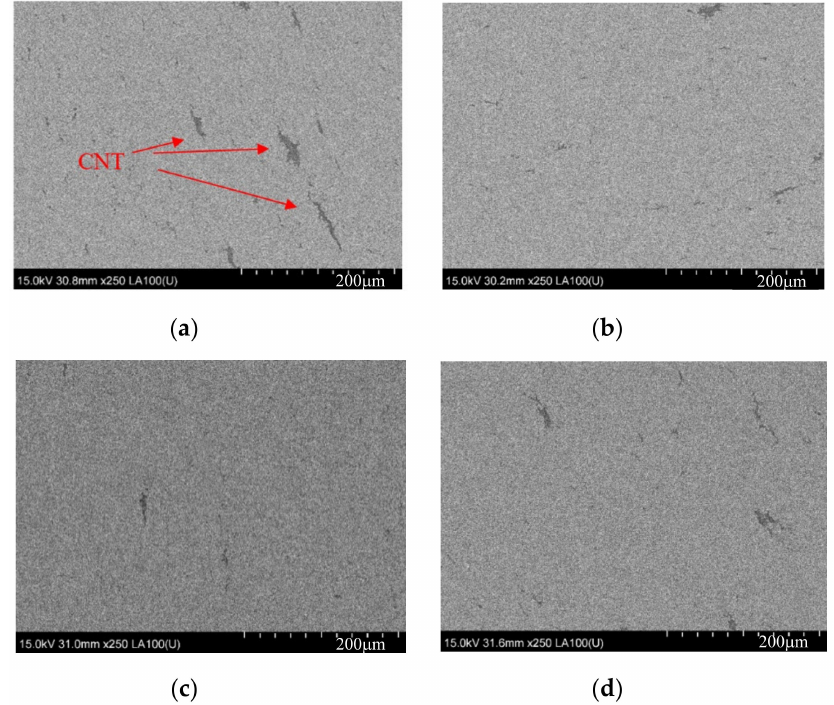
Figure 4. Cross-sectional SEM images for CNT / Al composites. CNT contents were 1.0 mass.% ( a ); 1.0 mass.% ( b ); 0.5 mass.% ( c ); and 2.0 mass.% ( d ). Ultrasonic treatment time was 1 h ( a ); 5 h ( b ); 3 h ( c ); and 3 h ( d ).